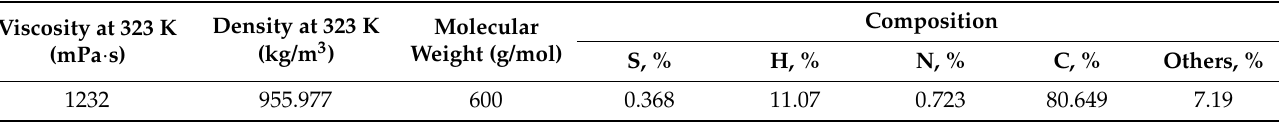
Table 1. Basic properties and composition of heavy